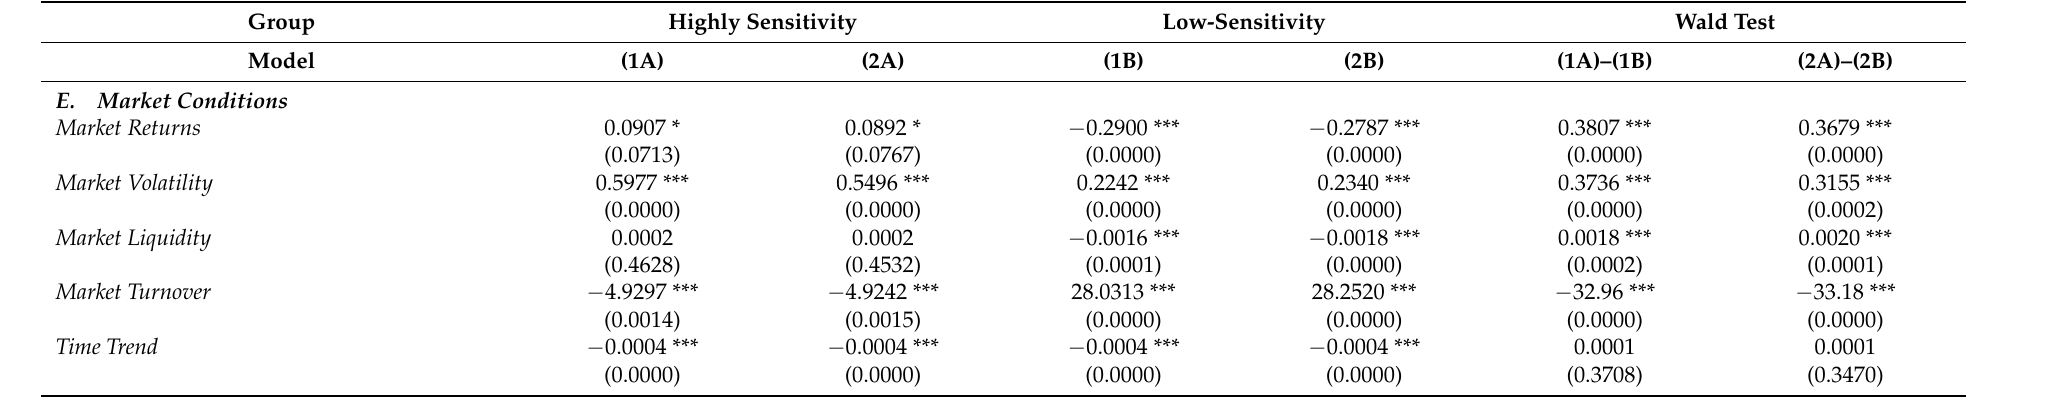
Table 5. Seemingly unrelated regressions of commonality in liquidity on sources of commonality for the high- and low-sensitivity groups. This table reports the results from SUR of 50 equations, representing the number of countries in our sample. All equations are jointly estimated for the period from January1995 to December 2015. In each model, we restricted the coefficients to be equal within each group but to vary across two groups. The first group includes the highly oil-sensitive countries (countries whose oil sensitivity ratio is above the median of all countries) and the second includes the less oil-sensitive countries (countries whose oil sensitivity ratio is below the median of all countries). The dependent variable is a log-transformed form of the commonality in liquidity measure, R 2 . Full definitions of all variables are presented in Table A1 in Appendix A. Mean and medians of adjusted Amihud R 2 reported in the last two rows are taken from separate optimum least squares regressions of all countries. In the last two columns, the Wald test is reported for the difference in the coefficients between